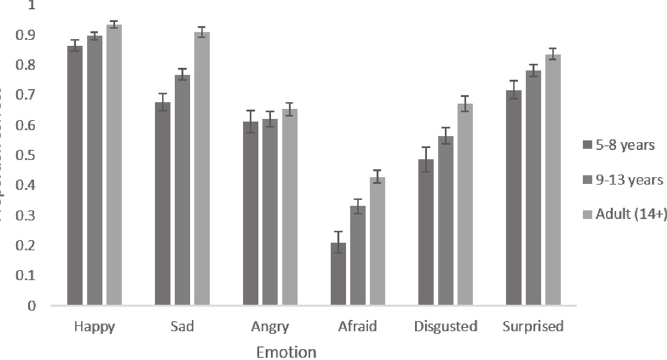
Fig 2. Mean proportion of correct responses to images showing each emotion by each participant age group. Error bars show standard error.